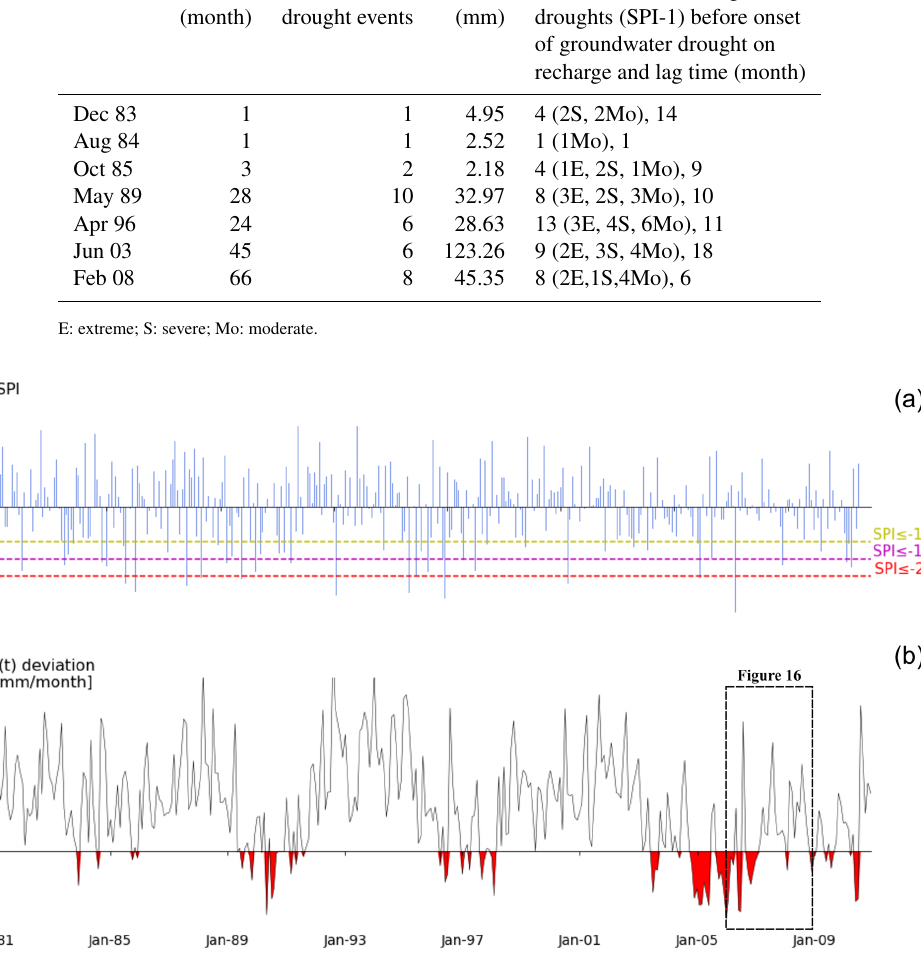
Figure 15. Comparison of meteorological drought severity and groundwater recharge drought. (a) Monthly SPI values and (b) groundwater recharge deviation from the threshold. The red color represents recharge drought